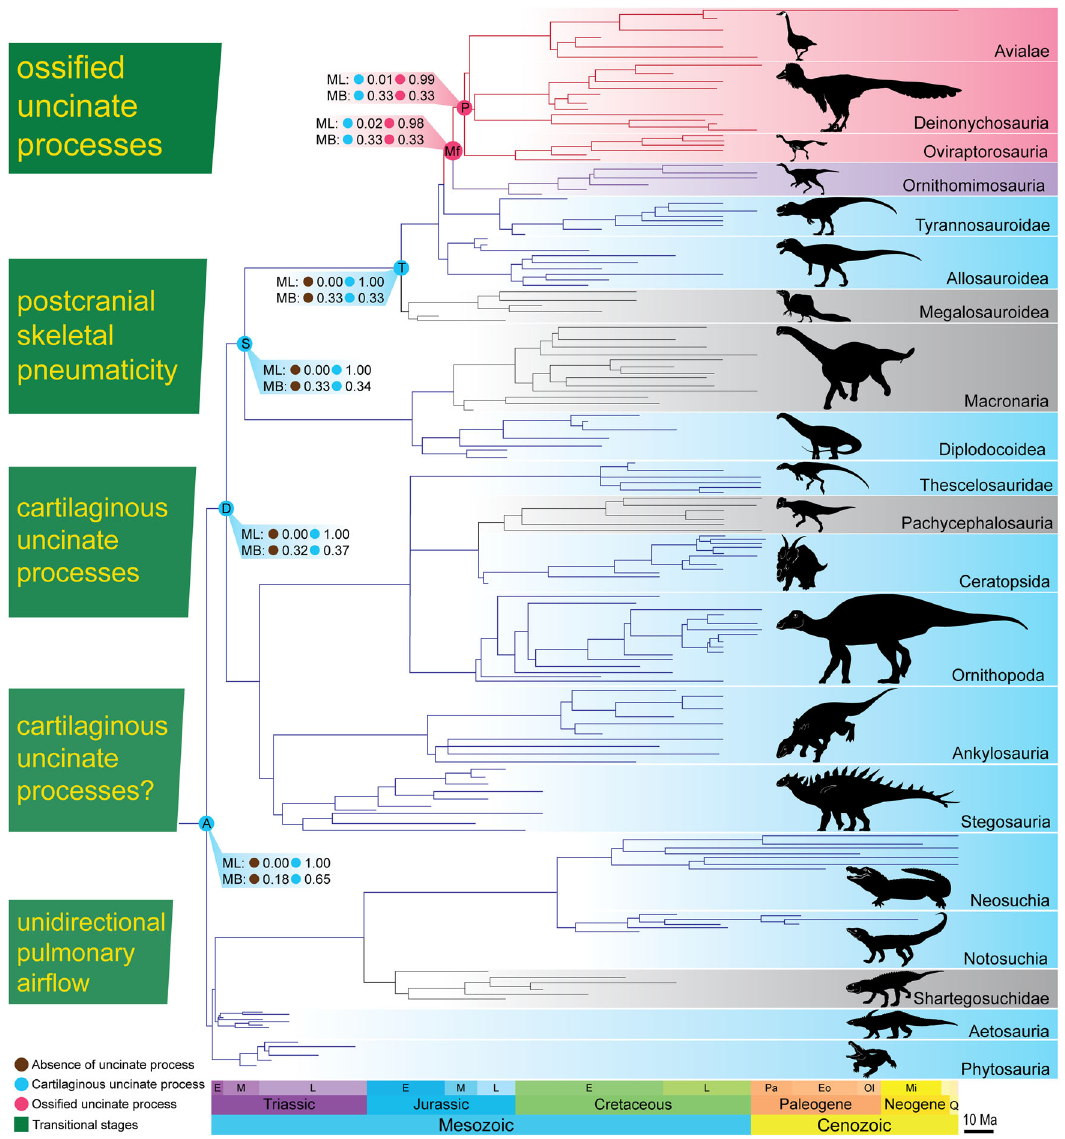
Fig. 3 Ancestral state reconstruction of uncinate processes in archosaurs. Results of ancestral state reconstruction on simpli fi ed version of informal consensus cladogram with branch length estimates, using preferred coding approach described in this study. Detailed description and raw data are provided in sections 3 to 6 of Supplementary Information. Nodes of interest are coloured according to the results from maximum parsimony, and estimated probabilities from maximum likelihood and Bayesian inference are indicated using text. Major clades of Archosauria with evidence of cartilaginous uncinate processes are labelled and shaded blue; clades with evidence of ossi fi ed uncinate processes are labelled and shaded pinkish red; clade with evidence of both cartilaginous and ossi fi ed uncinate processes is labelled and shaded purple; and clades for which no evidence is available are labelled and shaded grey. Complete results of ancestral state reconstruction for major clades are given in section 7 of Supplementary Information. Stages of hypothetical evolutionary scenario are outlined to left of cladogram. A Archosauria, D Dinosauria, E Early, Eo Eocene, L Late, M Middle, Mf Maniraptoriformes, Mi Miocene, MB Bayesian inference, ML maximum likelihood, Ol Oligocene, P Pennaraptora, Pa Paleocene, Q Quaternary, T